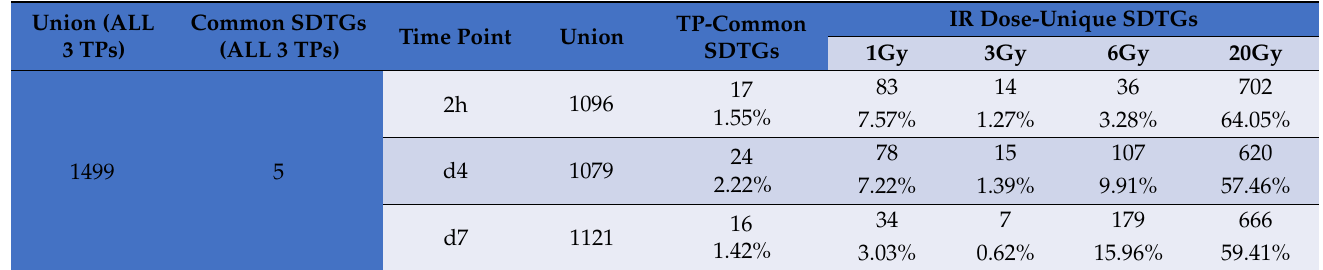
Table 6. Radiation-induced transcriptional modulations using SDTG ( p < 0.05 and FC ≥ 2) distribution in the first three time points and comparison of modulations in lethal and sublethal IR